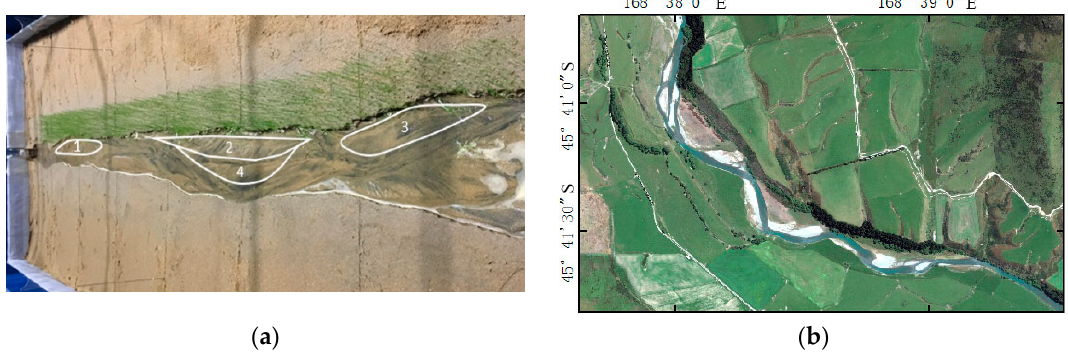
Figure 6. Channel morphology (( a ) Run 3 at t = 600 min); ( b ) the Mataura River near cattle flat (from Google Earth)).